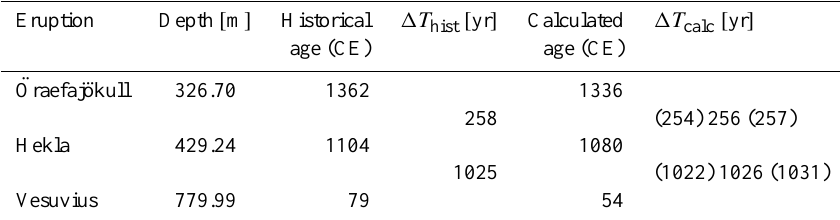
Table 2. Comparison of time intervals between three historically dated volcanic eruptions that are visible as marker horizons in the DYE-3 ice core. Depths are from Vinther et al. (2006). 1T hist are the historically known time intervals, 1T calc indicates the calculated time intervals and the inferred 95% confidence